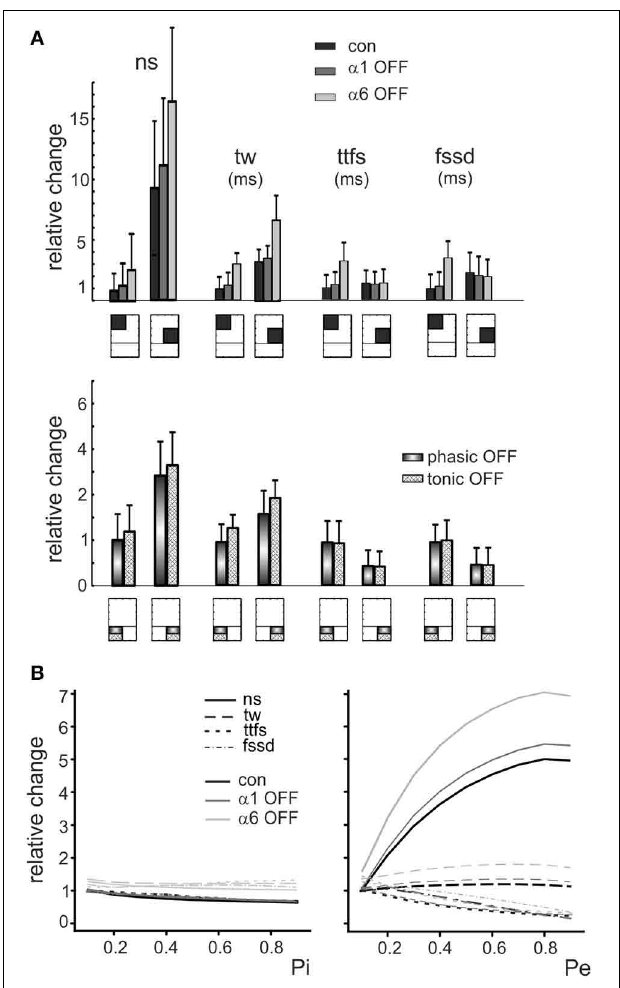
FIGURE 5 | The role of E/I and pE/pI in controlling granule cell firing parameters in response to mossy fiber bursts. (A) (Top) The relative changes of number of spikes ( ns ), time window ( tw ), time to first spike ( ttfs ) and first spike standard deviation ( fssd ) in control (con, black ) and after switch off of α 1 ( α 1-OFF, gray ) or α 6 ( α 6-OFF, light gray ) receptors is shown for the low- E/I and high- E/I quadrants identified in Figure 4B . It should be noted that the E/I balance primarily affects ns and tw .( Bottom ) The relative change of number of spikes ( ns ), time window ( tw ), time to first spike ( ttfs ) and first spike standard deviation ( fssd ) is compared with phasic inhibition off ( phasic OFF ) and tonic inhibition off ( tonic OFF ). Blocking tonic inhibition does not influence notably the effect of phasic inhibition on the time-related spiking parameters, time to first spike and first spike standard deviation. (B) The relative changes of number of spikes ( ns ), time window ( tw ), time to first spike ( ttfs ) and first spike standard deviation ( fssd ) are reported as a function of the inhibitory (and excitatory release probability ( Pi , Pe ), showing that Pi affects modestly the parameters, while raising Pe remarkably increases number of spikes and decreases time to first spike and first spike standard